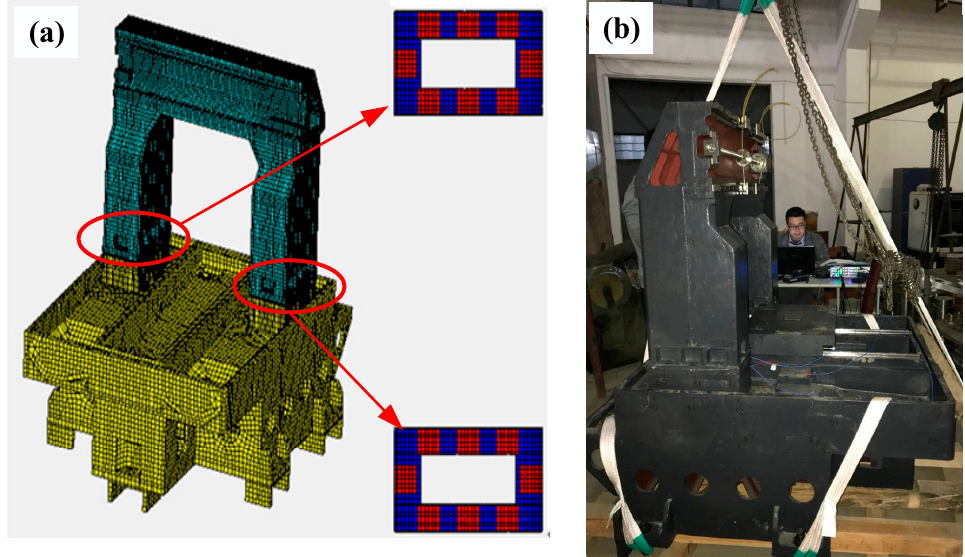
Figure 15. Compration of engraving machine: ( a ) Model mesh, ( b )modal experiment.